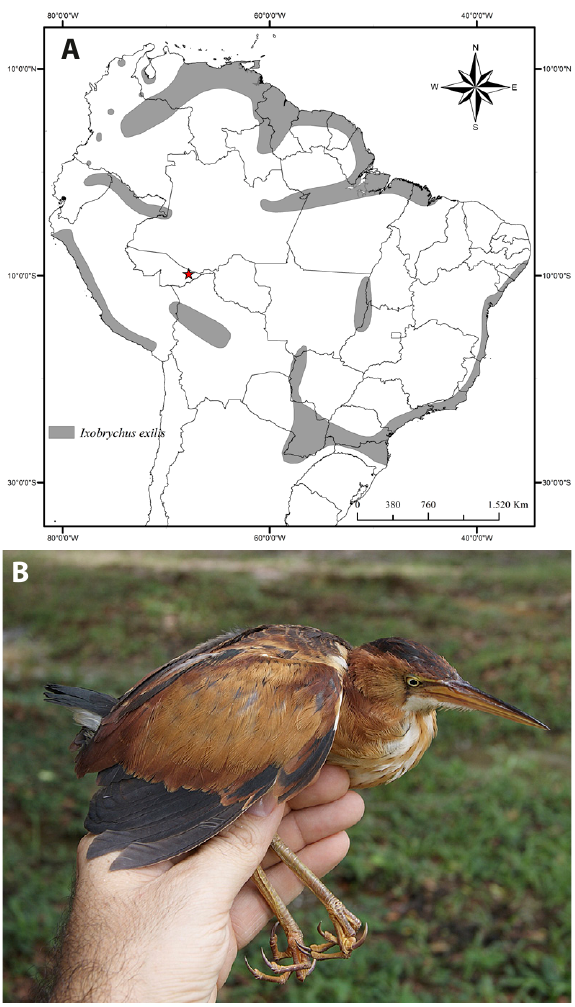
Figure 2. Paint-billed Crake ( Neocrex erythrops ). A. Range (grey) in South America. B. Documented records of the species presented in this study (red star) and by Whittaker et al. (2002) (black star). Photo by Jailini da Silva